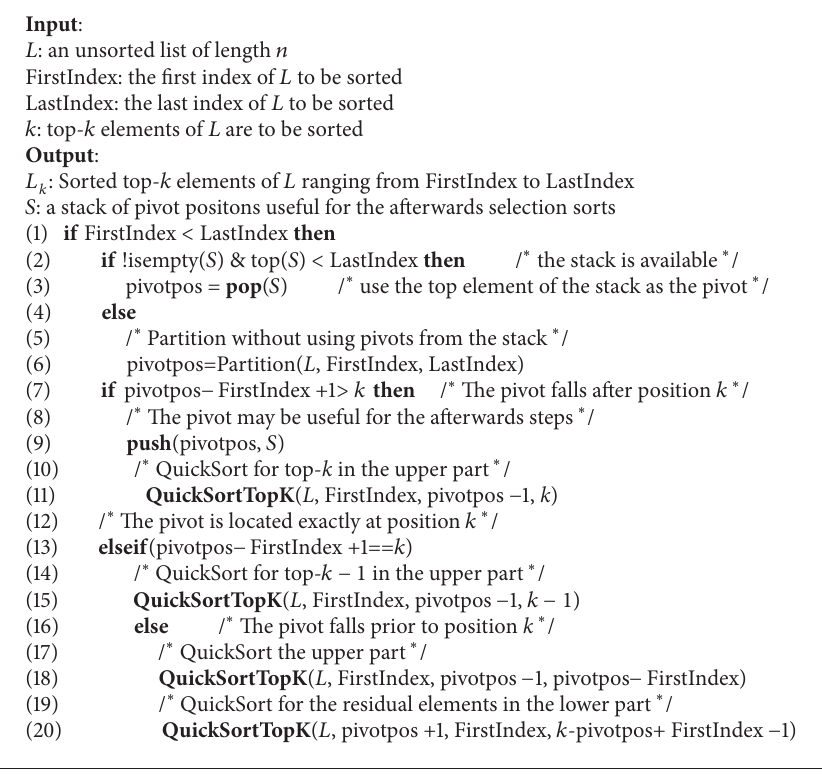
Algorithm 1: QuickSortTopK( 𝐿 , FirstIndex, LastIndex, 𝑘